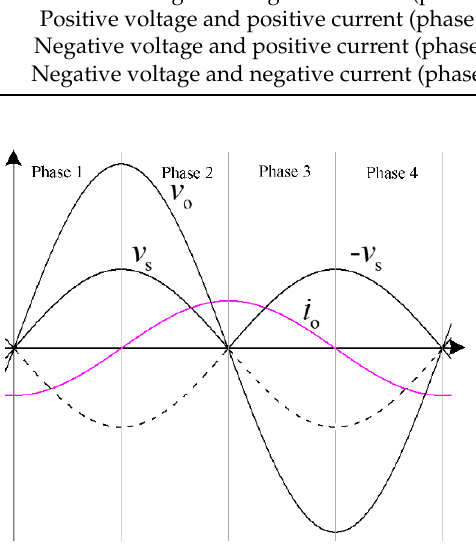
Figure 3. Input and output waveform diagram.